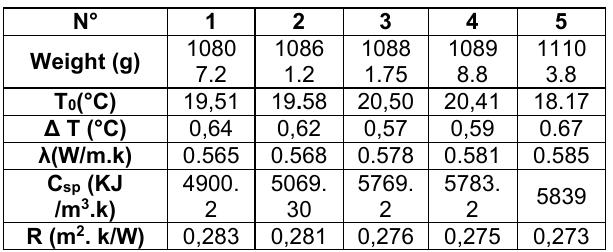
Table.6 Results of thermal experiments for the bricks on the scorched soil.